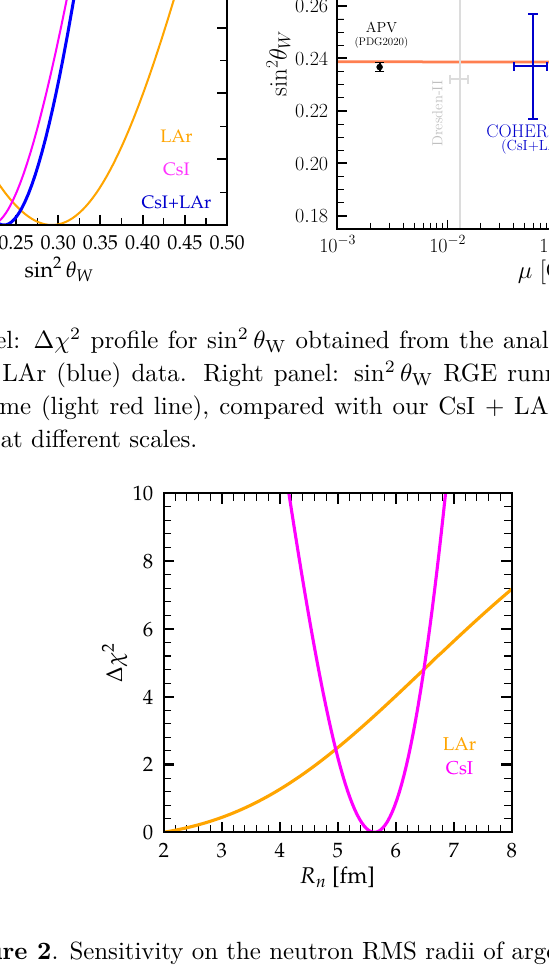
Figure 2 . Sensitivity on the neutron RMS radii of argon and